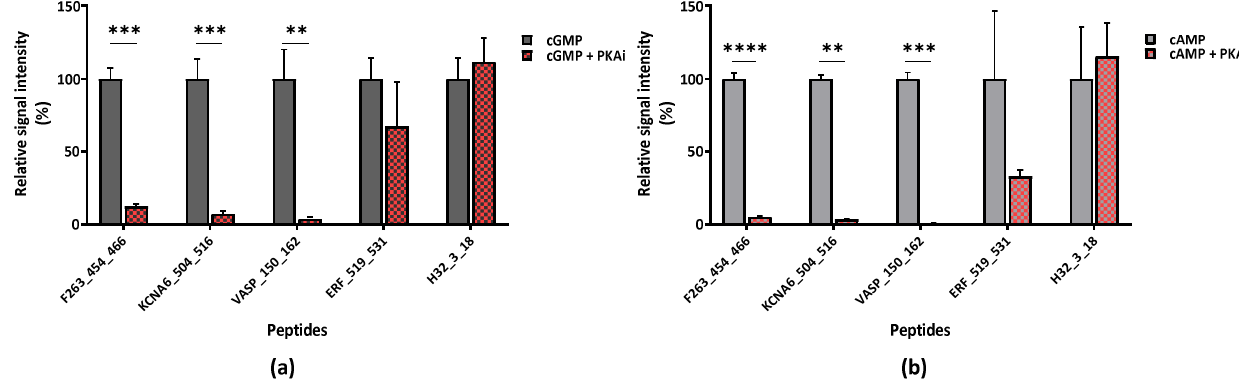
Figure 4. Phosphorylation of selected peptides by 661W cell lysate in the presence of either ( a ) cGMP (10 µM) or ( b ) cAMP (0.1 µM) with and without PKAi (1 µM). The significance of changes in cGMP and cAMPs was determined by unpaired T-tests with significance indicated as ** ( p ≤ 0.01), *** ( p ≤ 0.001) and **** ( p ≤ 0.0001) .